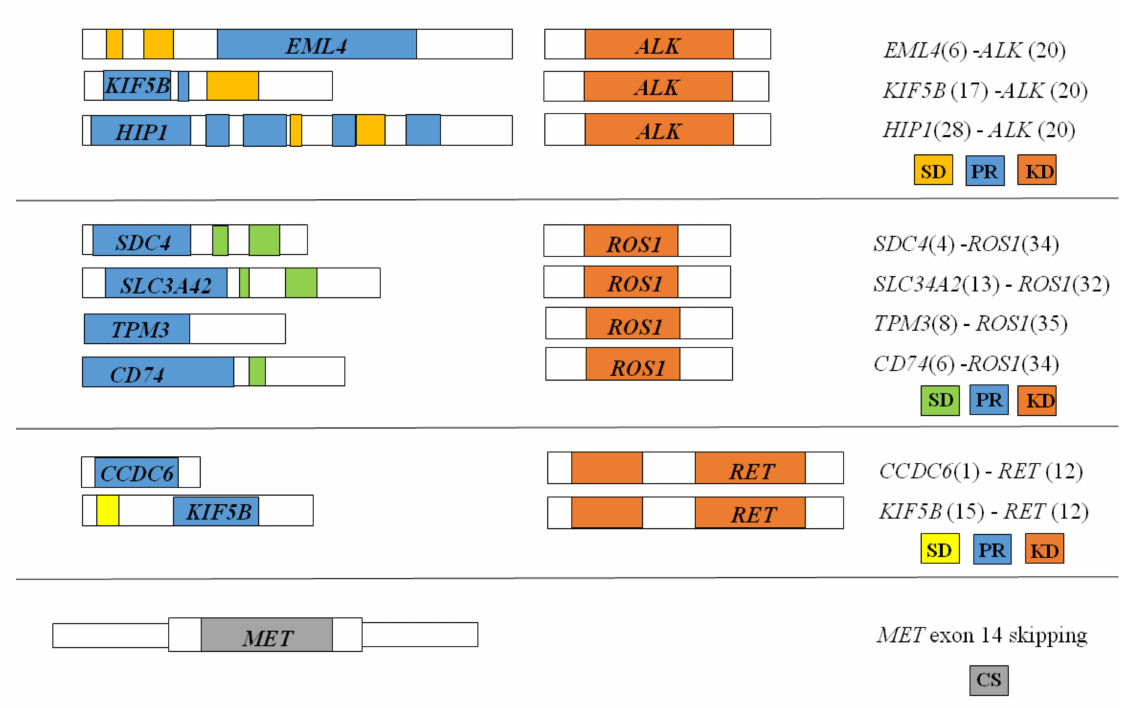
Figure 1. Schematic representation of gene fusions reported in a routine sample set: The kinase domain is in orange; the promoter region is in blue; the structural domains are in yellow, ochre, and green; the coding sequence is in grey. Abbreviations: ALK : Anaplastic Lymphoma Kinase; CCDC6 : Coiled-Coil Domain Containing 6; CD74 : CD74 Molecule, Major Histocompatibility Complex, Class II Invariant Chain; CS: sequence; EML4 : Echinoderm Microtubule Associated Protein Like 4; HIP1 : Huntingtin Interacting Protein 1; KD: kinase domain; KIF5B : Kinesin Family Member 5B; MET : MET Proto-Oncogene, Receptor Tyrosine Kinase; PR: promoter region; RET : Rearranged During Transfection; ROS1 : ROS Proto-Oncogene 1, Receptor Tyrosine Kinase; SD: structural domain; SLC34A2 : Solute Carrier Family 34 Member 2; SDC4 : Syndecan 4; TPM3 : Tropomyosin